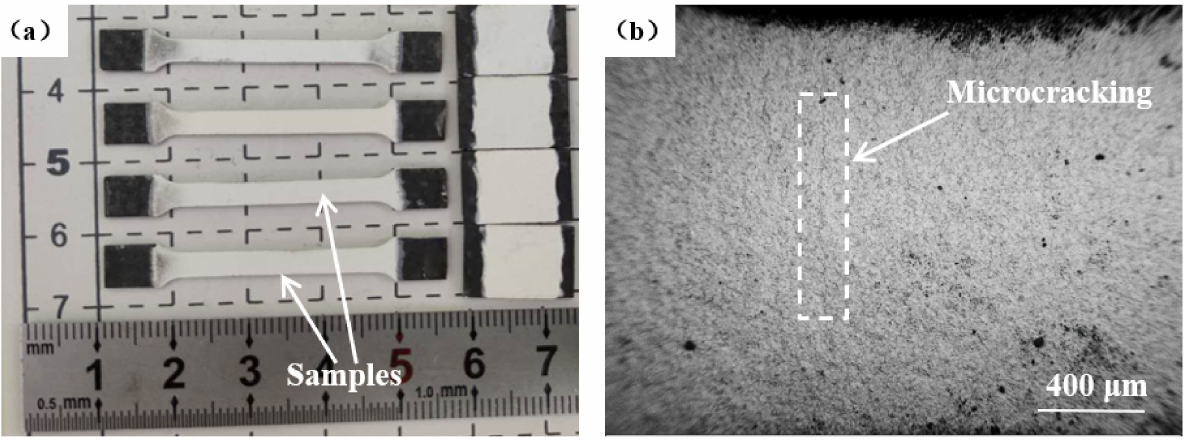
Figure 2. Specimen after spraying: ( a ) macro-scale photo; and ( b ) SEM